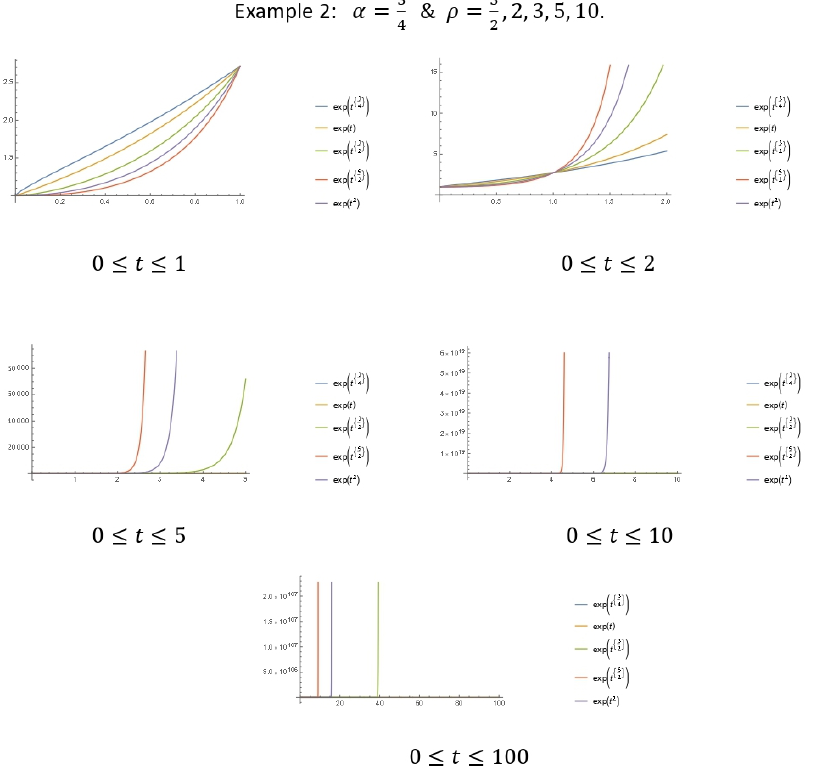
Figure 2. Graphical illustration of the energy growth bounds.